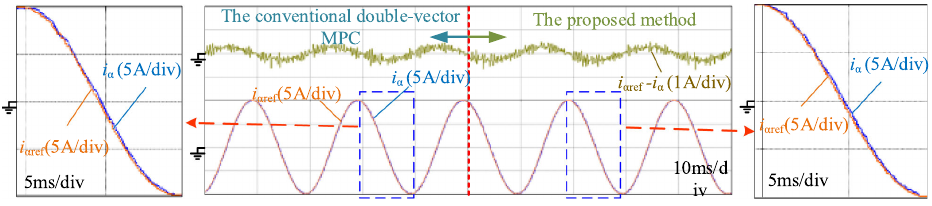
Fig. 13. Current THDs with different currents. Figure 12. Performance comparison of different approaches. ( a ) MPC with the ideal model. ( b ) MPC with model mismatch. ( c ) MPC with model mismatch. ( d ) Proposed MFPC.